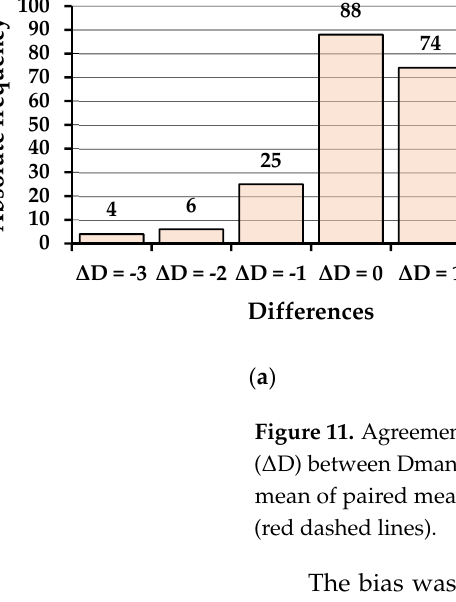
Figure 12. Relation between the diameters measured by the two methods (E2). Legend: red dashed line stands for perfect agreement and green dashed line stands for the dependence relation between Dmeas and Dman fitted by RTO. Similar to diameters, the results of length measurement were better in terms of agree- ment (Figures 13 and 14) compared to those from E1. Close to 26% (53 observations) were in full agreement, which was higher compared to E1, 55% of the data (110 observations)